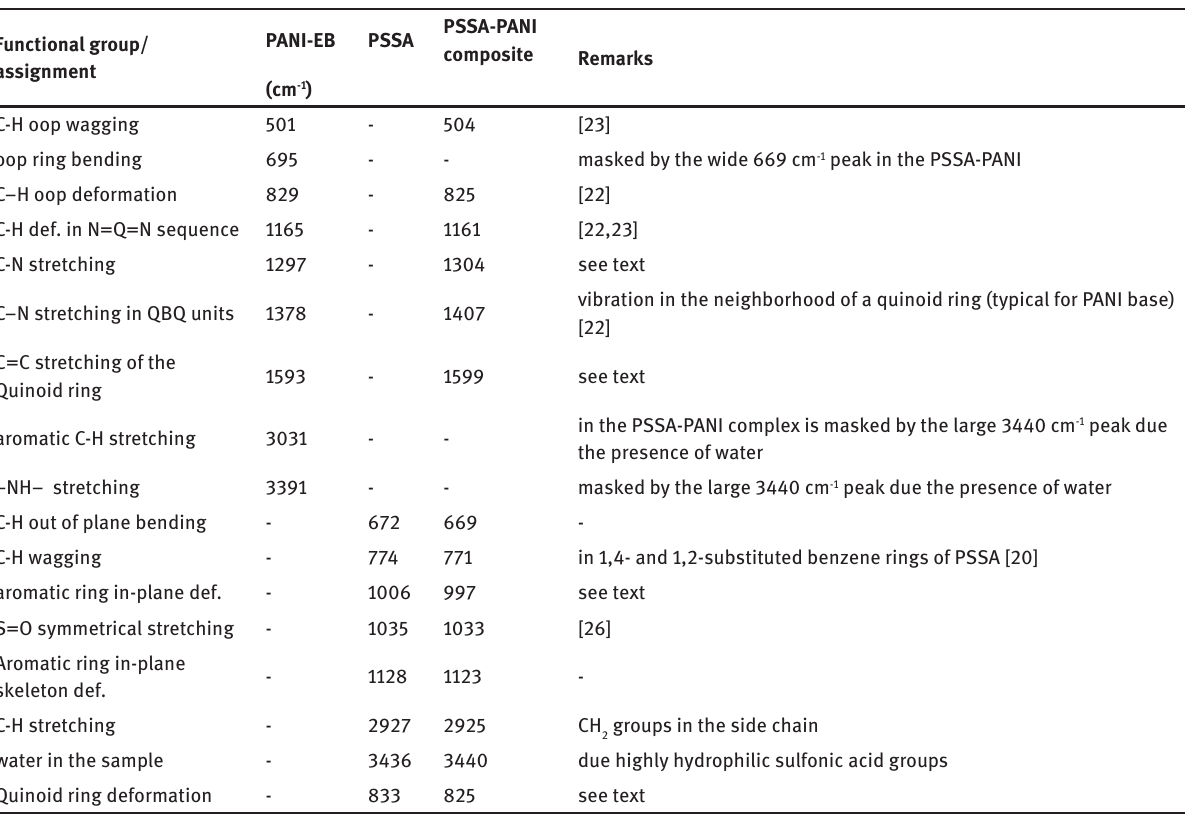
Table 1: Significant peaks recorded in PSSA, PANI-EB and PSSA-PANI complex.